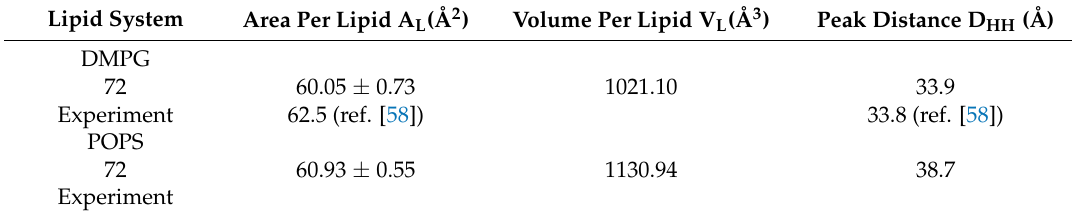
Table 1. Structural properties of bilayers calculated via molecular simulation using AMOEBA force field and comparison to limited experimental